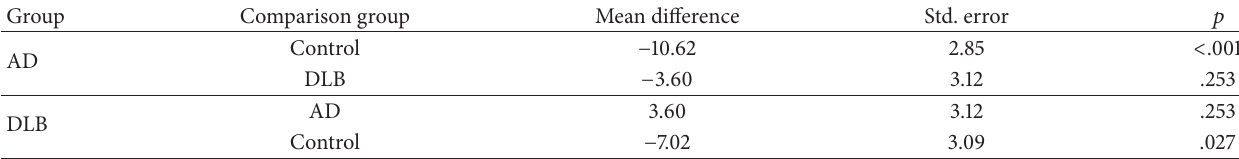
Table 5: Post hoc group comparisons (i.e., control, DLB, and AD) on measures of language. Group Comparison